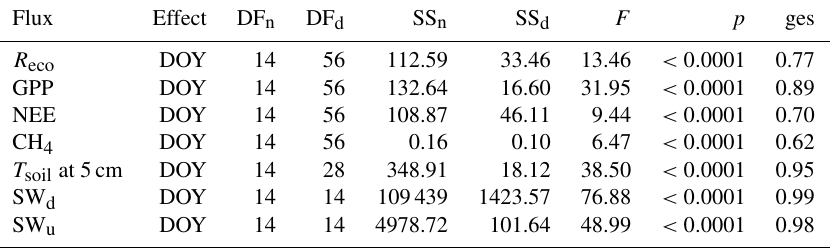
Table B1. Statistics of repeated measures ANOVA applied to the daily means of modeled fluxes, radiation measurements and T soil at 5cm at all sites over the whole observation period. (DOY denotes day of year; SW d denotes downwelling shortwave radiation; SW u denotes upwelling shortwave radiation; DF n denotes degrees of freedom in the numerator; DF d denotes degrees of freedom in the denominator; SS n denotes sum of squares in the numerator; SS d denotes sum of squares in the denominator; ges denotes generalized eta squared ( η 2